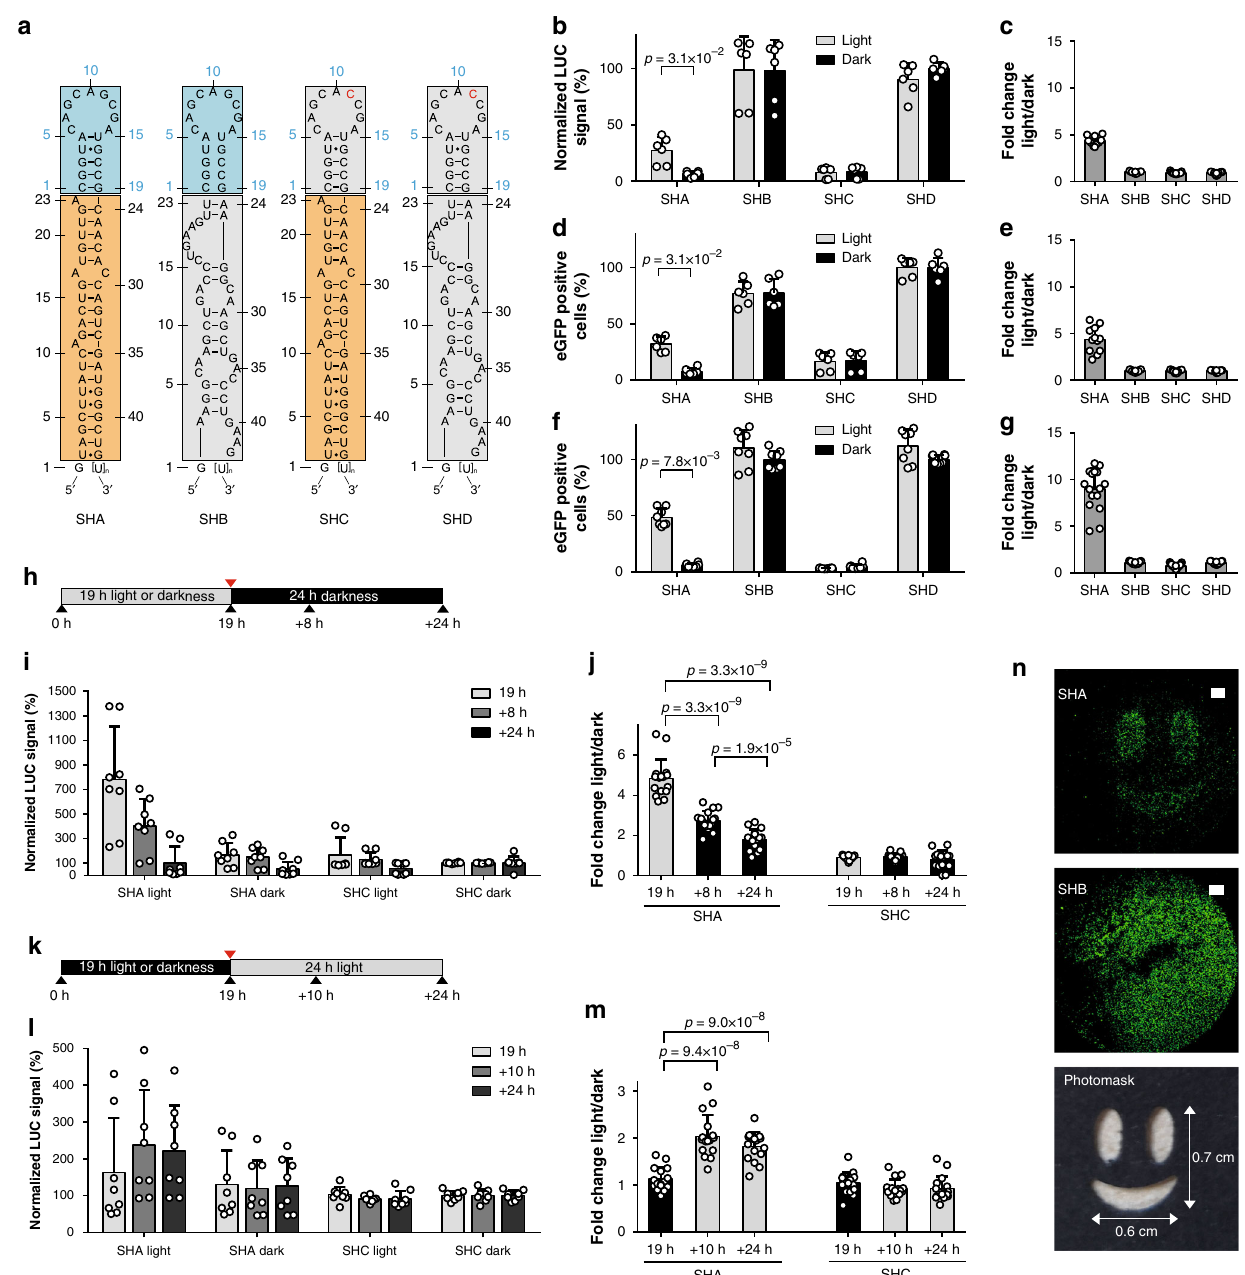
Fig. 2 A pre -miR21-aptamer chimera enables light-control of gene expression. a Schematic representation of the pre -miR21 variants and corresponding controls. Blue boxes: aptamer domain, orange boxes: miR21 domain, gray boxes: aptamer point mutant or control miR. b Luciferase expression after transfection of the indicated pre -miR21 variants. Values are normalized to SHD incubated in darkness. c Fold changes calculated from light vs . dark conditions from ( b ). d Number of cells expressing eGFP after transfection of the indicated pre- miR21 variants. Values are normalized to SHD incubated in darkness. e , Fold changes calculated from light vs . dark conditions from ( d ). f Number of cells expressing eGFP in the presence of elevated levels of AGO2 and after transfection of the indicated pre -miR21 variants. Values are normalized to SHD incubated in darkness. g Fold changes calculated from light vs . dark conditions from ( f ). N = 6 ( b , d ), 8 ( f ), 12 ( c , e ) or 16 ( g ). b – g Each biologically independent experiment was performed in duplicates. b , d , f Gray bars: light conditions, black bars: dark conditions. c , e , g Dark gray bars: fold changes. b – f Wilcoxon two-sided signed-rank test was used for statistical analysis as a paired observation was assumed. h Illumination protocol applied in ( i ) and ( j ). i Luciferase expression level of cells expressing SHA or SHC. Shown are normalized values to SHC in darkness. j Fold changes calculated from light vs . dark conditions from ( i ). k Illumination protocol applied in ( l ) and ( m ). l Expression level of luciferase of cells expressing SHA or SHC. Shown are normalized values to SHC in darkness. m Fold changes calculated from light vs. dark conditions from ( l ). b – m Values are means ± s. d. N = 8 ( i , l ) or 16 ( j , m ). Each biologically independent culture was performed in duplicates. j – m Two- sided Mann – Whitney U test was used for statistical analysis as an unpaired observation was assumed. n Spatial patterning of eGFP expression after transfection with SHA (top panel) or SHB (middle panel). Irradiation was done on cells covered with a photomask (bottom panel); white bars: 1000 µ m. Source data for ( b – g , i , j , l , m ) are provided as a source data fi